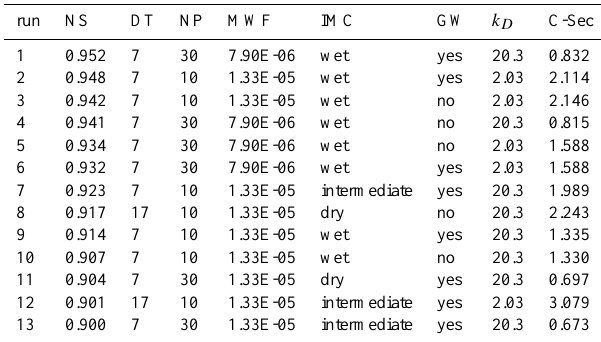
Table 2. Parameters and goodness of fit criteria to characterise the 13 model setups. NS: is the Nash-Sutcliffe efficiency, DT: differ- ences between modelled and simulated time to peak, NP: number of macropores per unit area [m − 2 ], MWF: maximum volumetric water flow in a macropore [m 3 s − 1 ], IMC: initial moisture condi- tions (the wet case corresponds to a suction head of − 50.66 hPa throughout the profile; the intermediate case had a suction head of − 303.98 hPa in the upper 40cm of the profile and − 101.33 hPa be- low this layer; the dry setting corresponds to a head of − 405.3 hPa in the upper 40 cm of the profile and − 151.99 hPa in the remaining soil profile), k D : tile drain conductivity [cm s − 1 ], GW: Groundwa- ter occurrence, C-Sec: drained width of the cross-section in meters adjusted to match the